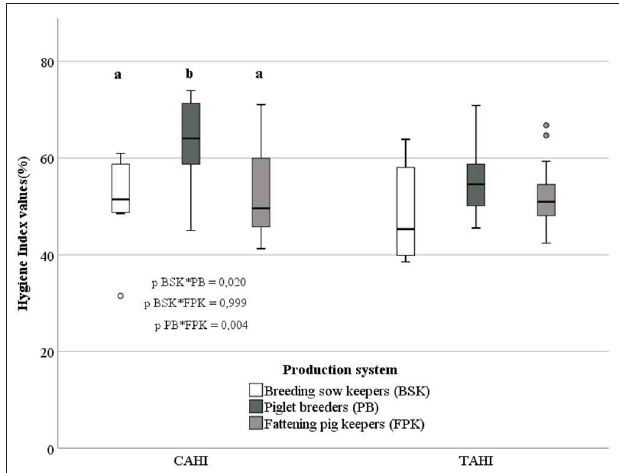
FIGURE 4 | Box-and-whisker plot of continuous and “technical animal hygiene index” values (%) according to the pig production systems. Different letters indicate significant differences (ANOVA and Hochberg GT2 procedure; α = 0.05); p -values of pairwise comparisons are given below the box-and-whisker plots.